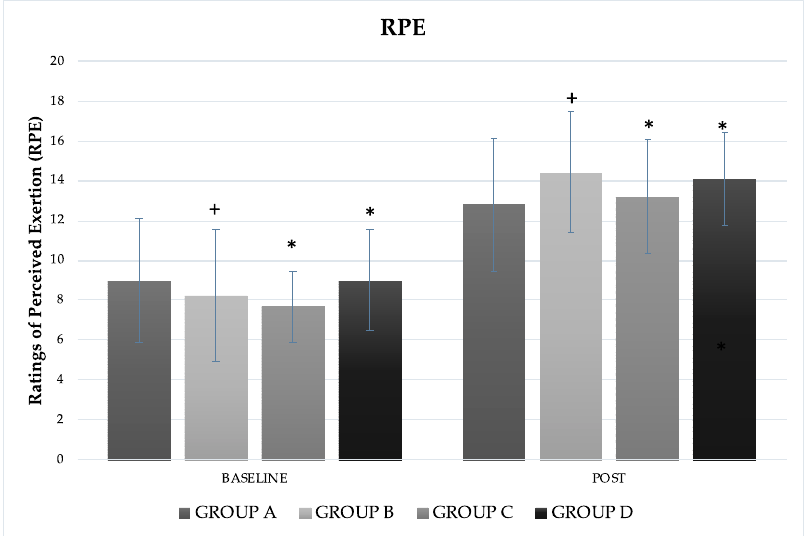
Figure 1. Ratings of Perceived Exertion (RPE) measured before and after the intervention. + = Significant differences p < 0.001. * = Significant differences p < 0.005.